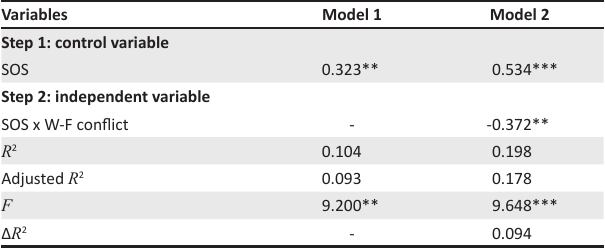
TABLE 2(b): Results of hierarchical regression analyses for the prediction of family satisfaction.